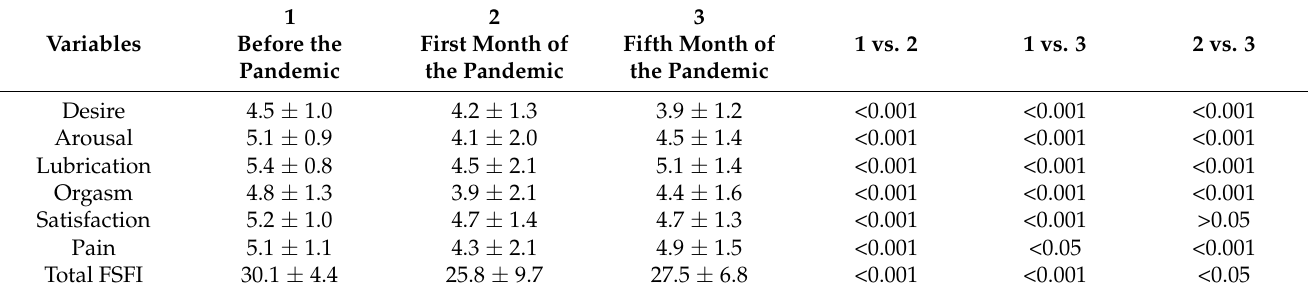
Table 2. Comparison of FSFI scores before, in the first and in the fifth month of the COVID-19 pandemic. Statistical significance was set at p <